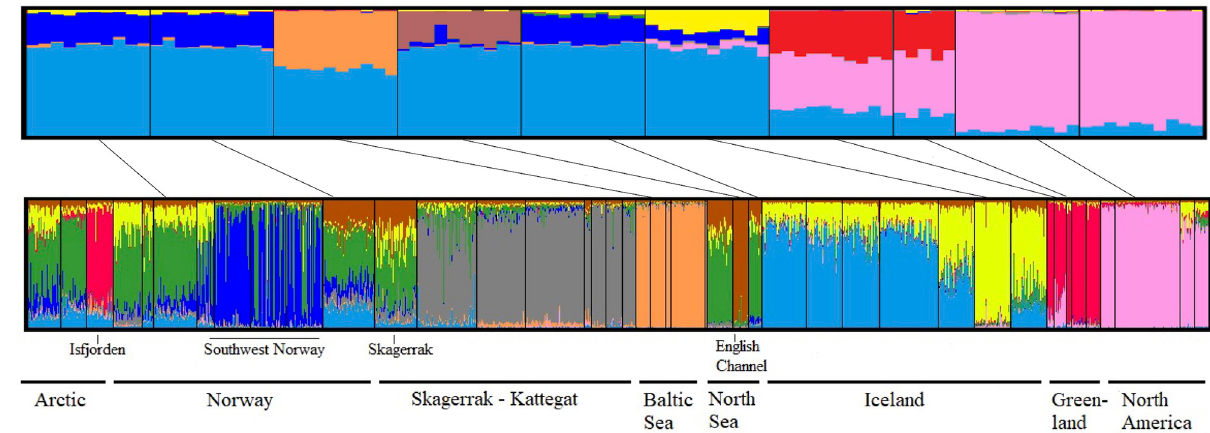
Fig 3. Assignment of lumpfish ( Cyclopterus lumpus ) into genetic K clusters for the genome-wide dataset with 4,393 SNPs (K = 7) in the top panel, and targeted dataset with 139 SNPs (K = 9) in the bottom panel. Each bar is one individual and the different colors represent the proportional assignment to the different K clusters. Samples that were genotyped with both methods are connected with black lines between the top and bottom panel.